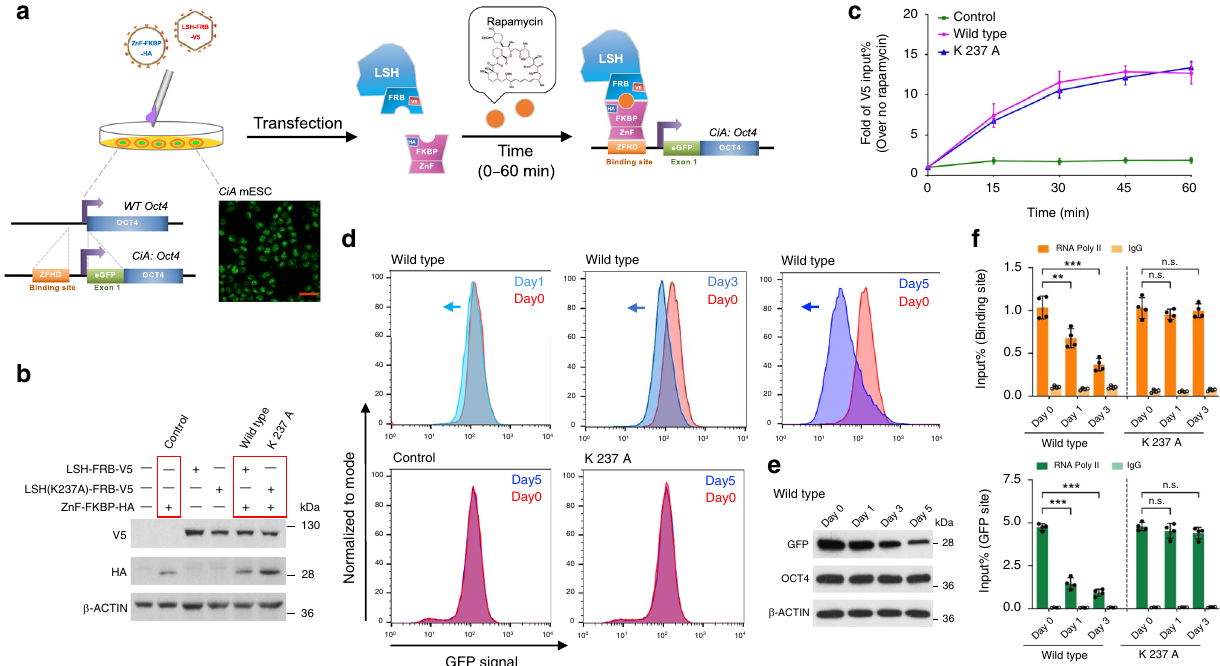
Fig. 1 LSH tethering induces transcriptional repression. a Schematic graph to illustrate recruitment of FRB-tagged LSH by rapamycin to the CiA: Oct4 locus in the CIP system. Rapamycin dimerizes with FRB and FKBP. The CiA: Oct4 mouse ES cells contain one modi fi ed Oct4 allele harboring one array of DNA binding sites (12 × ZFHD1) in the promoter region upstream of an in-frame eGFP reporter inserted in exon 1 of the Oct4 gene. Scale bar, 40 μ m. b Western blot analysis for detection of LSH (wild type)-FRB-V5, LSH (K 237 A)-FRB-V5 (ATP mutant site), and ZnF-FKBP-HA fusion proteins in the engineered mouse ES cells using V5 and HA antibodies. Cells expressing both fusion proteins were used to establish the CIP system, and cells lacking LSH fusion protein served as controls. c ChIP-qPCR analysis using V5 antibody for detection of wild-type and ATP mutant LSH (K 237A) protein recruitment to the Oct4 locus site within 60 min after rapamycin treatment in the CIP system ( n = 3 independent experiments). Cells that lacked LSH fusion protein served as controls. Data are represented as mean ± SD. d Flow cytometry was used to measure reporter-GFP expression after recruitment of wild-type or ATP mutant LSH (K 237A)-FRB-V5 fusion protein at indicated time points in the CIP system. Cells that lacked LSH fusion protein served as controls. e Determination of GFP and OCT4 protein level by WB after rapamycin treatment at indicated time points in the wild-type LSH CIP system. f ChIP-qPCR analysis to determine Pol II enrichment at the ZFHD binding site and GFP reporter site at indicated time points in the wild-type and ATP mutant LSH